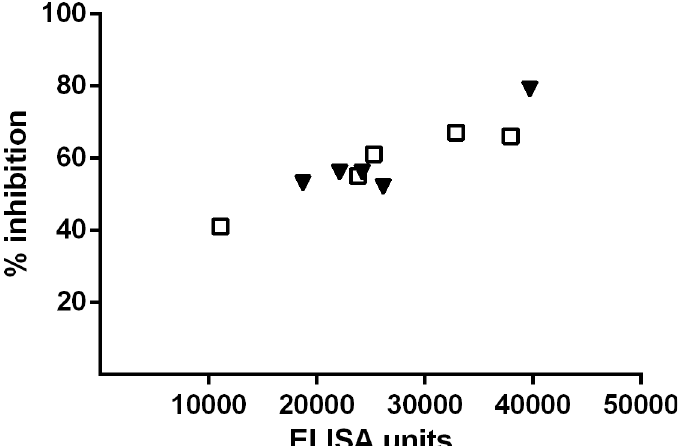
Fig 6. Inhibition of parasite growth in vitro with purified IgG from immunized rabbits. Y axis shows % inhibition, and X axis shows the concentration of AMA1-specific antibody used in the assay. Closed triangles represent individual rabbits vaccinated with un-conjugated AMA1. Open squares represents rabbits vaccinated with the AMA1-AMA1 particle.